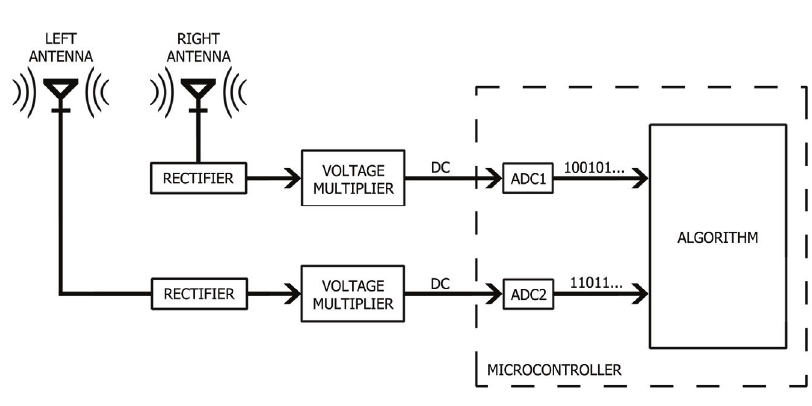
Figure 4. Diagram of the RF harvesting